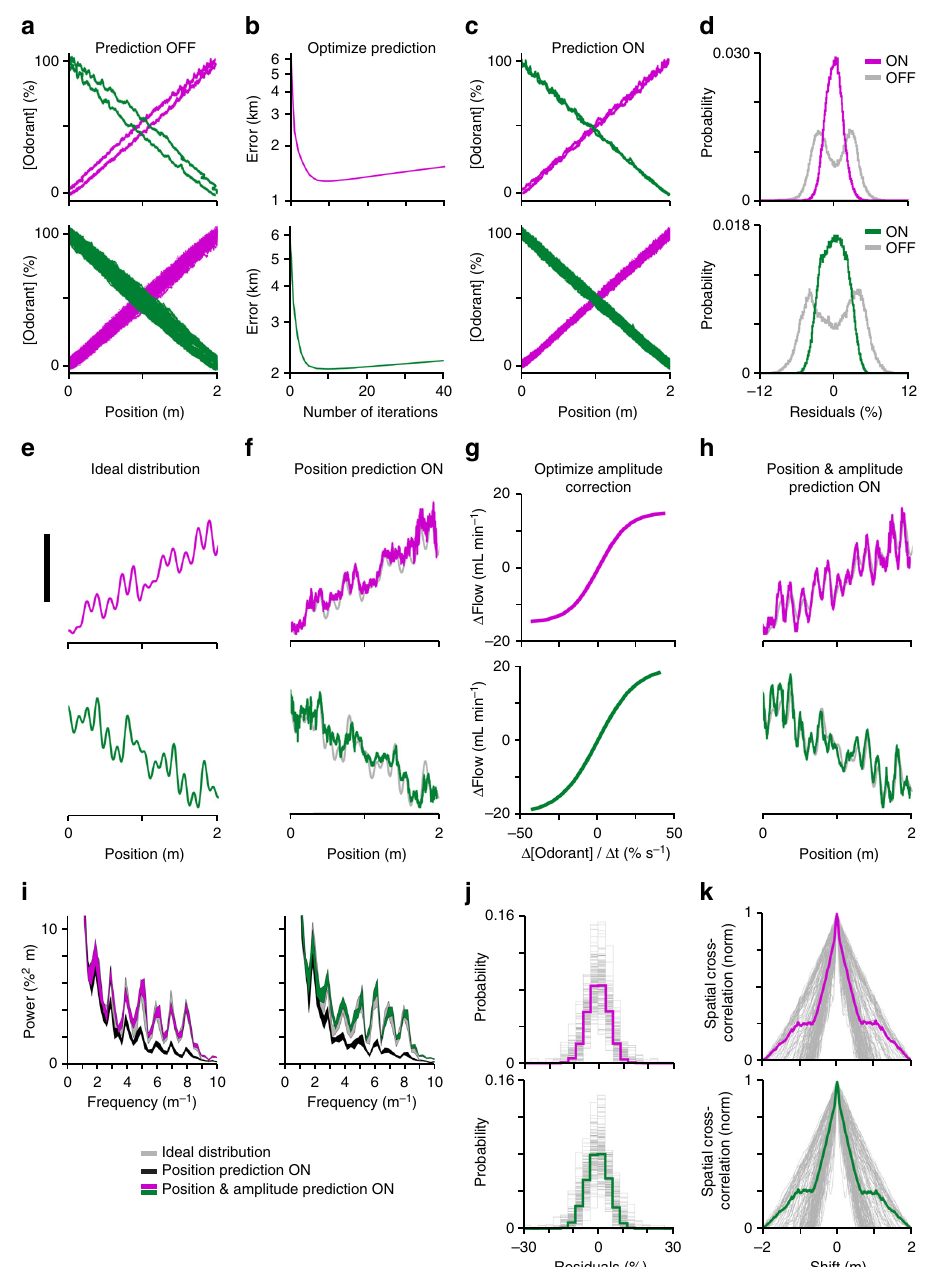
Fig. 2 Online algorithms enhance the precision of odorant delivery. The data were acquired by replaying a recording of the same 30-min behavioral session with the PID at the nose chamber. a – d A position-predictive algorithm tightens a smooth odorant spatial distribution. a Odorant delivery with no position- predictive algorithm for two traversals, one toward methyl valerate and one toward α -pinene (top), and for the entire behavioral session (bottom). b The window for calculating instantaneous velocity for the position-predictive algorithm was optimized of fl ine by minimizing the error between real and predicted position for each odorant. c Odorant delivery with the position-predictive algorithm on. d Residuals of the data in a (bottom) and c (bottom) to their best- fi t lines. With the position-predictive algorithm off, the time lag described in a resulted in an odorant distribution that was skewed in the opposite direction of the run, causing a bimodal distribution of residuals (gray), one mode for each run direction. This distribution was made unimodal (color) when the position-predictive algorithm was turned on. e – k Adding an amplitude correction to the position-predictive algorithm permitted the control of a high- frequency noisy odorant distribution. e The ideal noisy odorant distribution for one traversal for methyl valerate (top) and α -pinene (bottom). Scale bar = 30%. f Odorant delivery with the position-predictive algorithm alone. g The amplitude correction was determined by how much extra fl ow was needed to achieve the concentration rate of change to generate the ideal odorant distribution (Supplementary Fig. 5). h Odorant delivery with the combined position- amplitude-predictive algorithm. i Power spectra of the ideal noisy odorant distributions (gray), and the real noisy odorant distributions with the position- only (black) and position-amplitude (color) predictive algorithms on ( n = 205 traversals, mean ± s.e.m). Peaks occured at the ideal frequencies (integers 1 – 8 m − 1 ) with the position-amplitude predictive algorithm on. j Histograms of the residuals between the real and ideal noisy odorant distributions with the position-amplitude-predictive algorithm on for each traversal ( n = 205, gray) and for all traversals pooled (color). k Spatial cross-correlation plots between each real and ideal distribution ( n = 205, gray) and averaged over all distributions